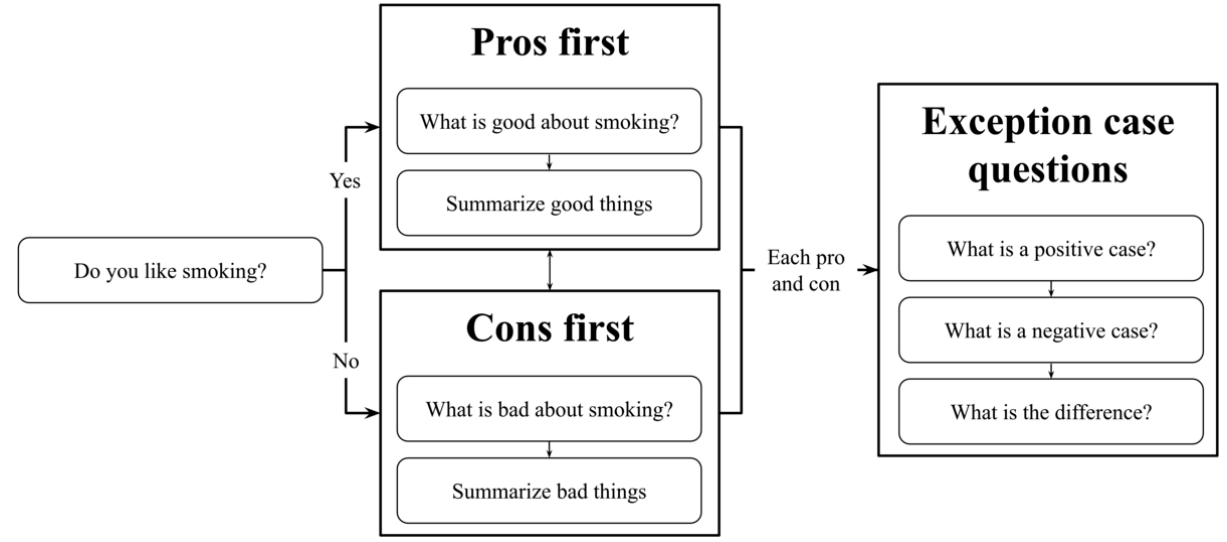
Figure 1. Overall flow of reflection phase of